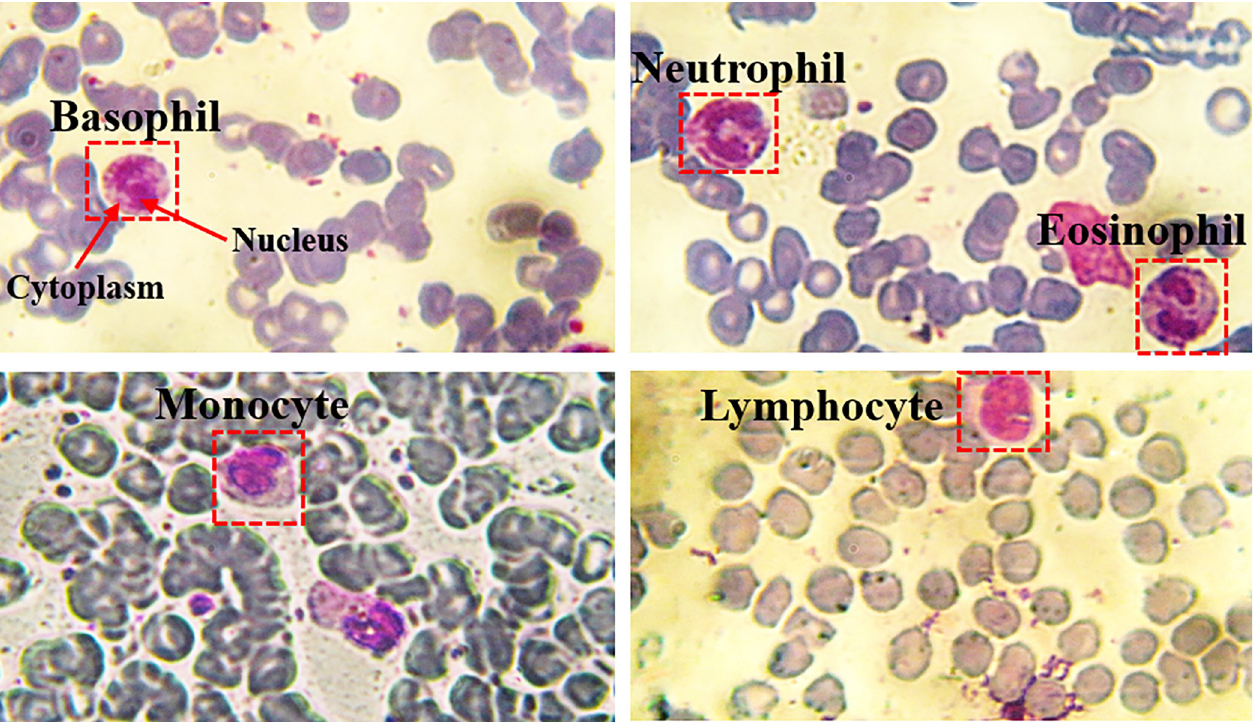
Fig 1. The five different kinds of WBCs in PBF images of normal blood samples with a magnification of 60X. Note that, the depicted images are captured at National Institute of Laser Enhanced Science “NILES”, Cairo University.